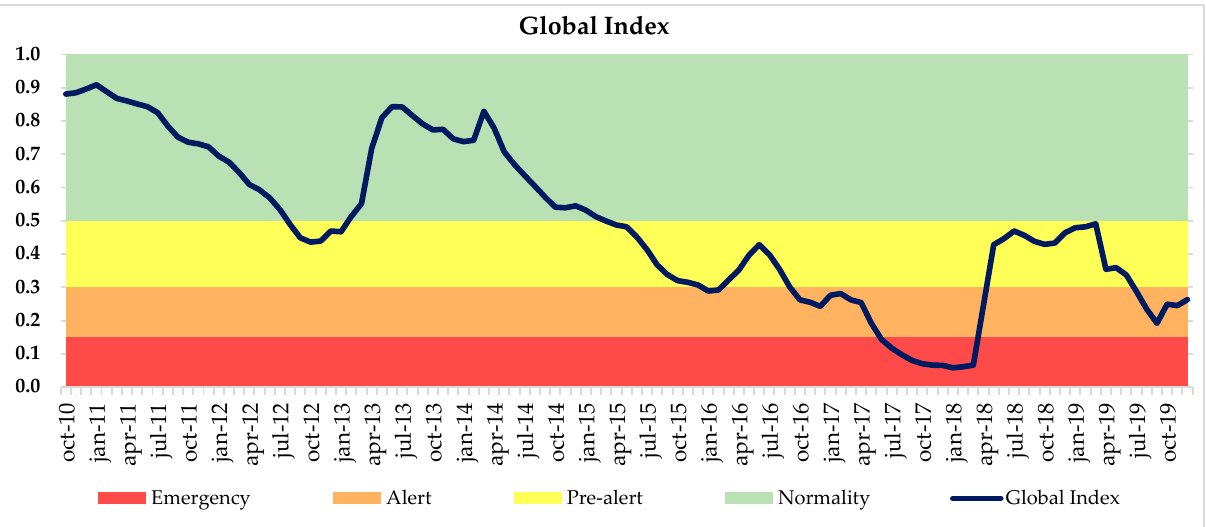
Figure 12. Evolution of the Global Index (temporary scarcity) in the Segura Basin, period October 2010–December 2019. Source: own elaboration based on [64].